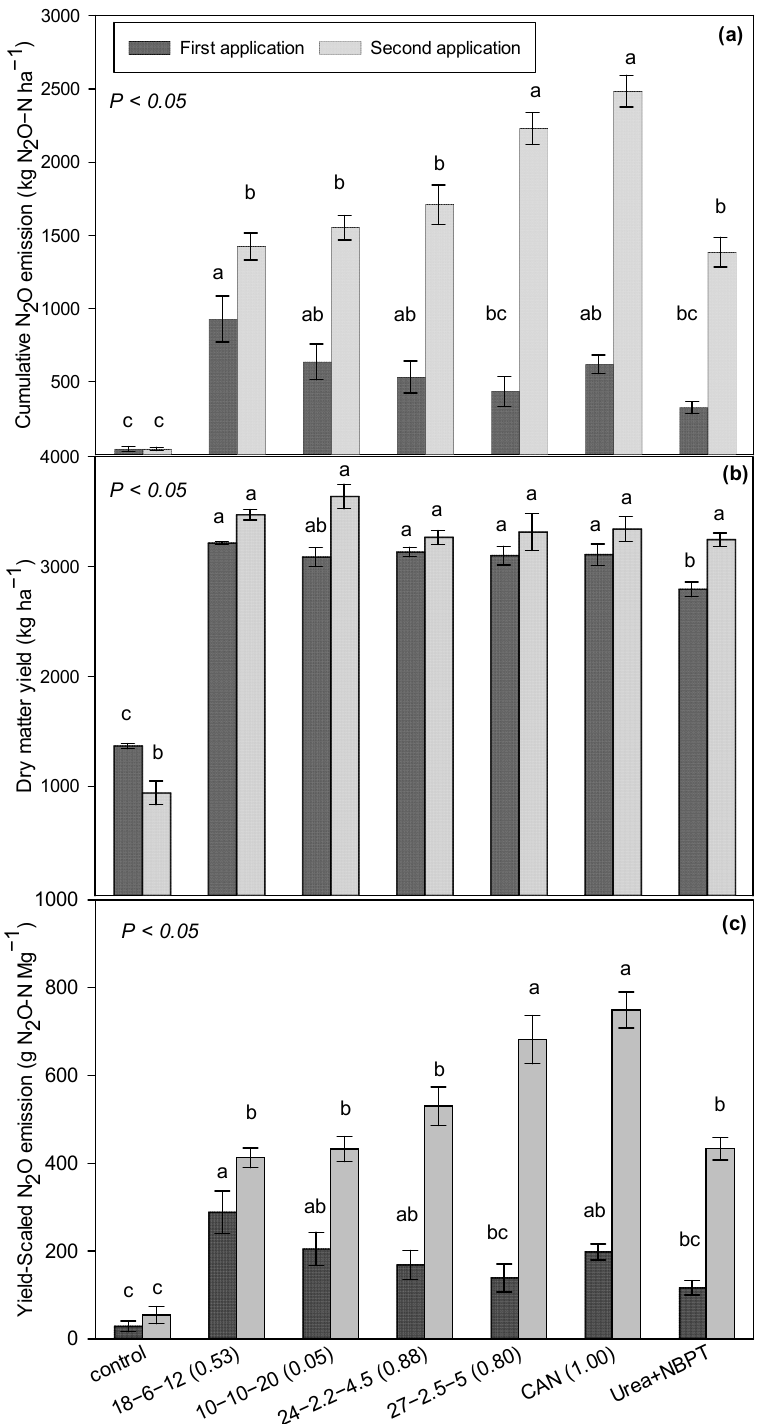
Figure 4. Cumulative N 2 O emissions ( a ), dry matter yield ( b ), and yield-scaled N 2 O emission ( c ) in the first and second fertiliser application in a growing season of temperate grassland with different fertiliser treatments. Error bars represent standard errors. Statistical differences are based on mixed linear model with the Tukey’s HSD post hoc test (95% significance level). Means that do not share a letter are significantly different. Comparisons are between fertiliser treatments within the same N 2 O condition. The numbers in parenthesis indicate the NO 3 − to NH 4 + ratio of the fertilisers.